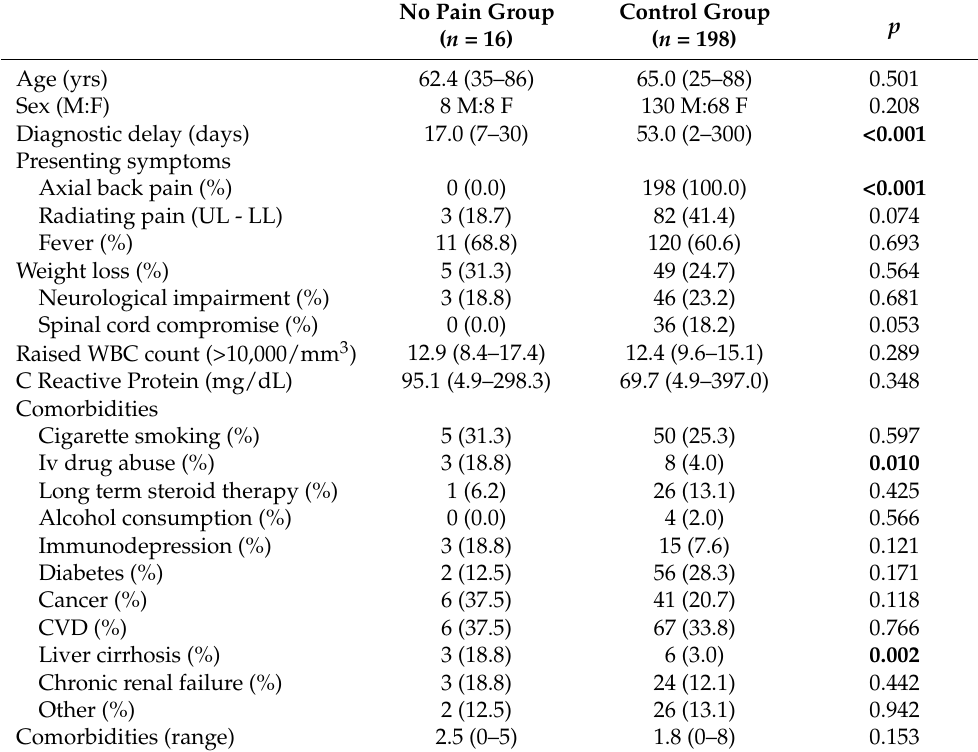
Table 1. Baseline demographics at